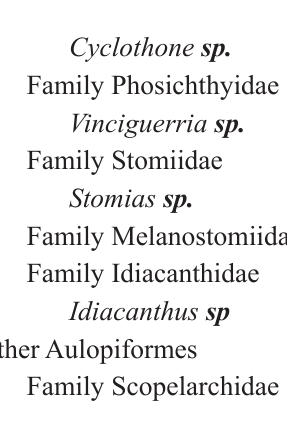
Figure 4 - Zooplankton biomass (g/100m 3 ) in the west tropical Atlantic